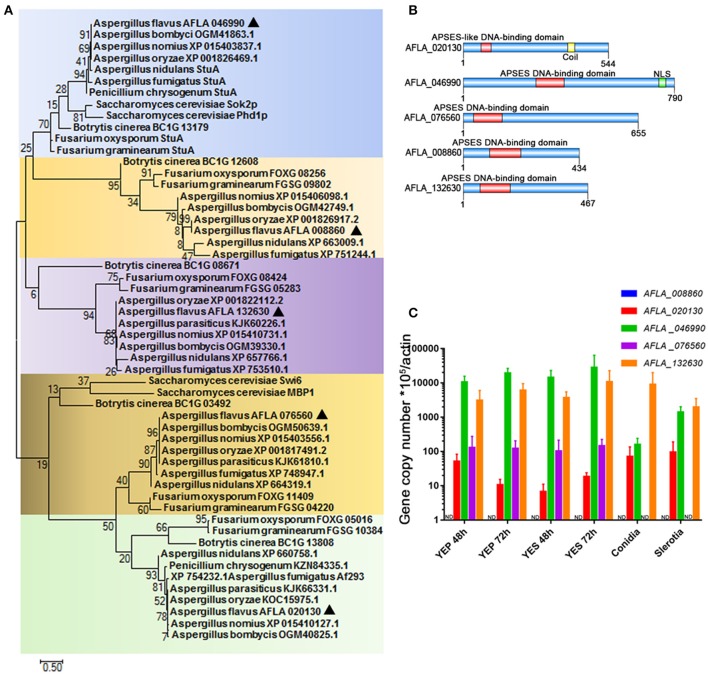
APSES transcription factor in A. flavus. (A) Phylogenetic analysis of the APSES protein orthologs AFLA_008860, AFLA_020130, AFLA_046990, AFLA_076560, and AFLA_132630. Both A. flavus APSES proteins and their orthologs were downloaded from the NCBI database, and sequence alignment and Maximum-likelihood tree were constructed using the software MEGA 7.0.21 (Kumar et al., 2016). (B) Schematic depiction of the APSES transcription factors (from top to bottom: AFLA_020130, AFLA_046990, AFLA_076560, AFLA_008860, and AFLA_132630) from A. flavus
(C) Expression profile of APSES TFs encoding genes from A. flavus under various conditions (YEP, YES, conidia, and sclerotia).